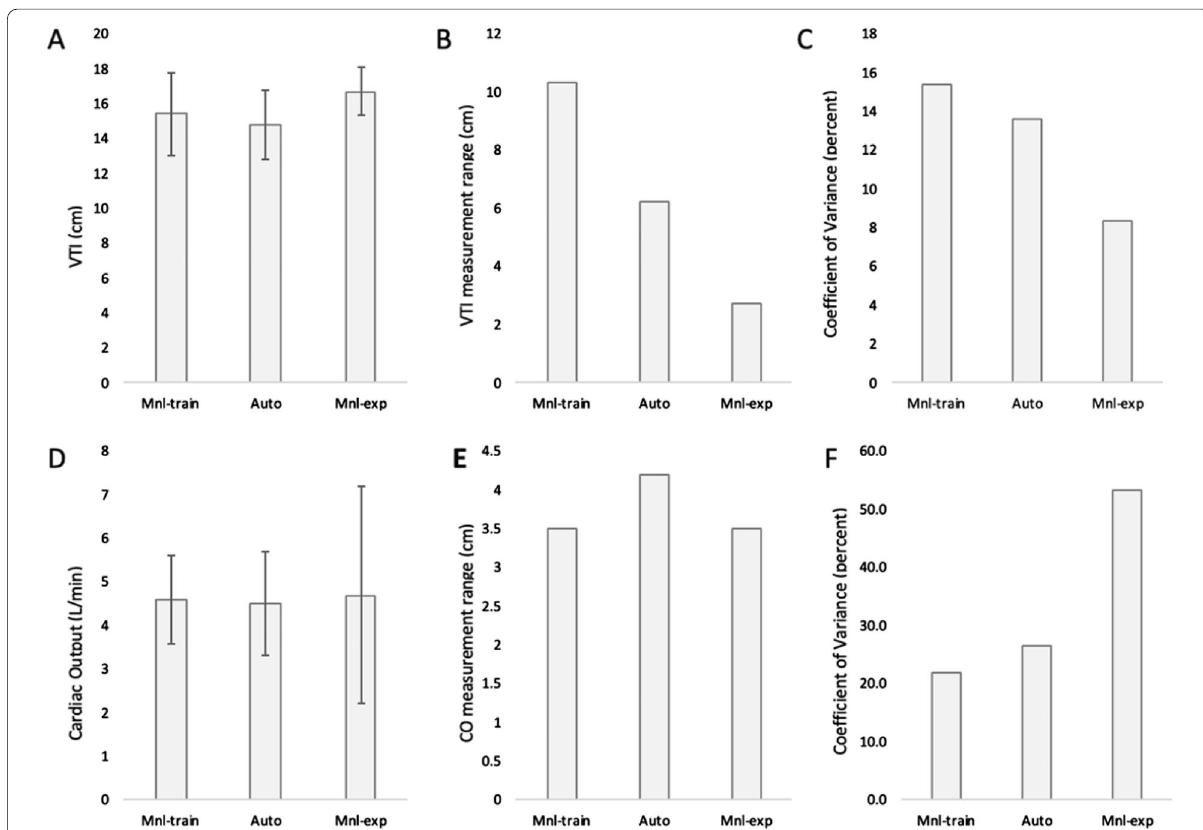
Fig. 1 Comparison between manually obtained measures by trainees (Mnl‑train), automated measurements (Auto), and manual measurements of certified ultrasonographers (Mnl‑exp). A Mean velocity time integral (VTI), B range of obtained VTI measurements, C coefficient of variance of VTI measures, D mean cardiac output (CO), E range of obtained CO measurements, F coefficient of variance of CO